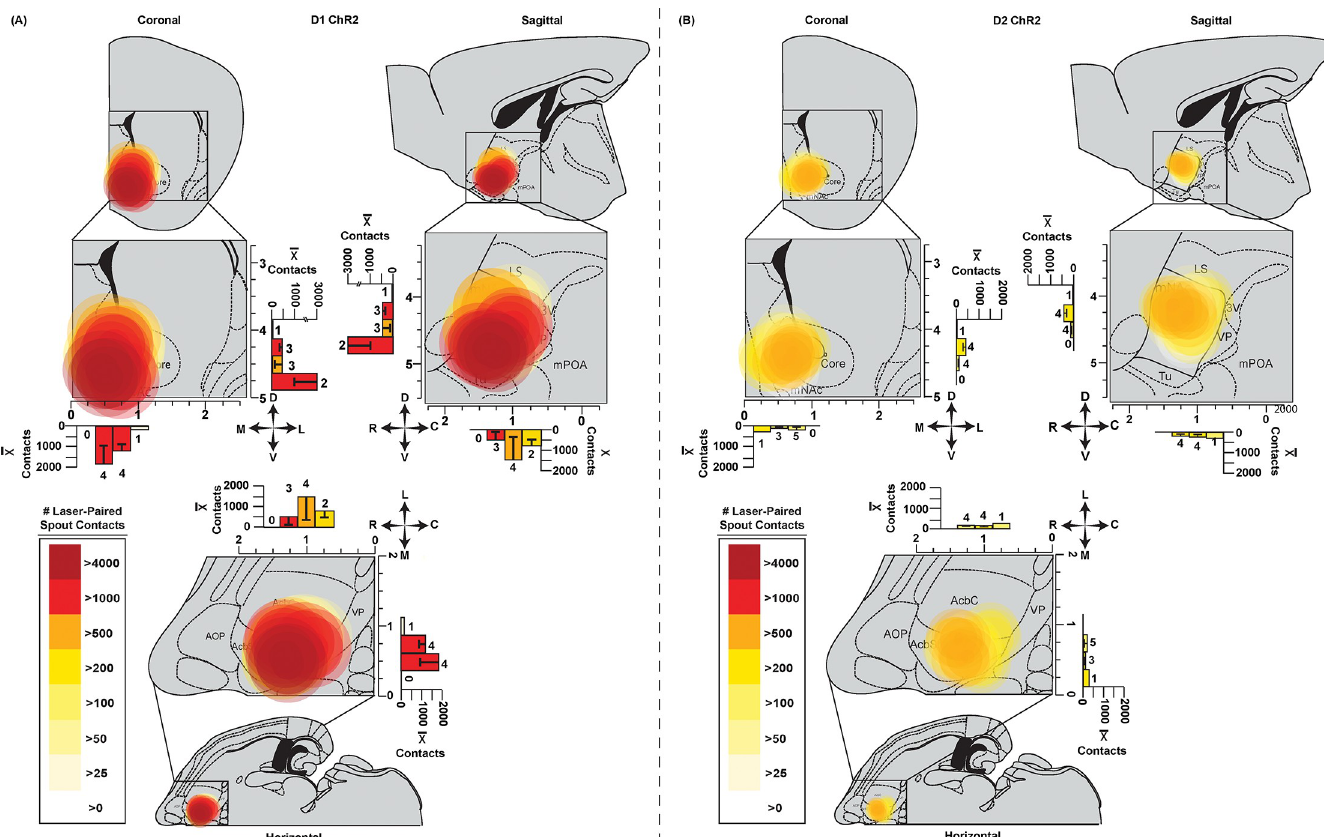
Fig 4. Anatomical sites in NAc: Shell and core sites support self-stimulation. Circle symbol locations show individual D1 (A) or D2 (B) sites in coronal, sagittal, and horizontal planes. Circle colors show the level of self-stimulation supported at each site (measured in the same mouse). Symbol sizes show the mean diameters of concentric Fos plumes (produced by laser illumination of ChR2 prior to perfusion). Two fiber optic placements per animal for D1 mice (n = 9) or D2 (n = 9) mice are mapped on to coronal, sagittal, or horizontal images. (A) D1 sites were within NAc medial shell or core which supported similar levels of 500 to 4000 self-stimulations per spout session. (B) D2 ChR2 sites were similarly within either NAc shell or NAc core, and generally supported self-stimulation at levels between showed moderate rates of 50 to 400 self-stimulations per